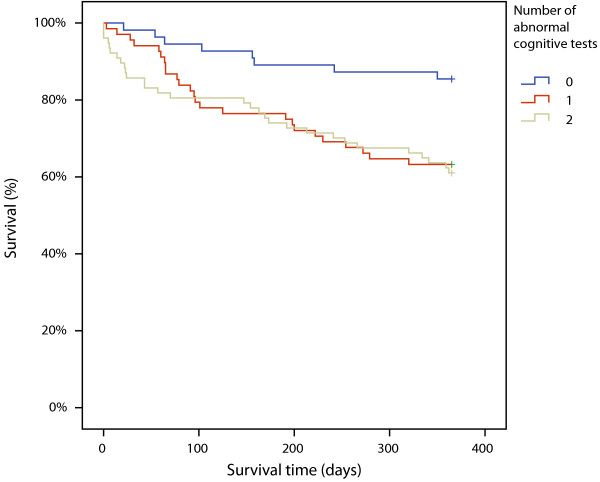
Kaplan-Meier estimates of 12-month survival for the three groups with 0, 1 and 2 abnormal cognitive test results. Log rank χ2(df = 2, N = 200) = 9.7, p = 0.008.